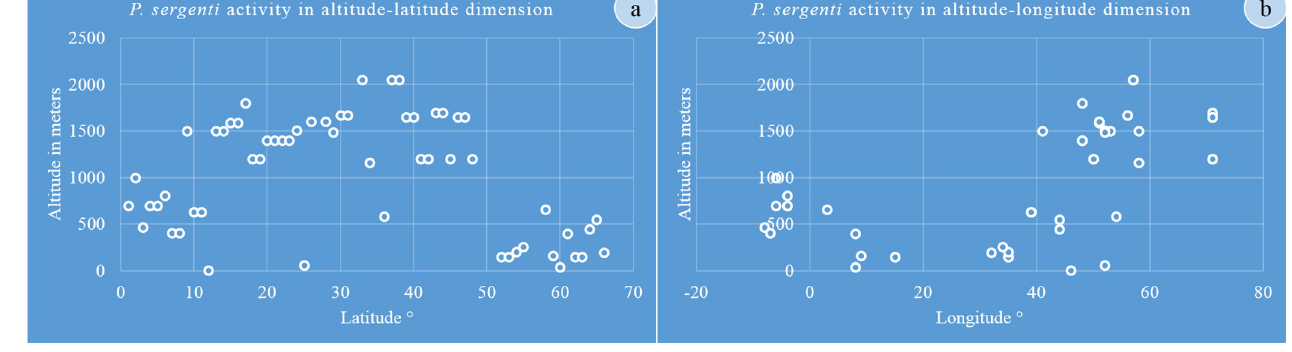
Fig 10. P . (Par . ) sergenti seasonal activity according to (a) Altitude- Latitude and (b), Altitude-Longitude.